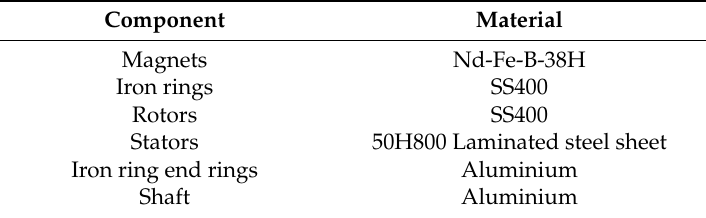
Table 2. Material properties of components.